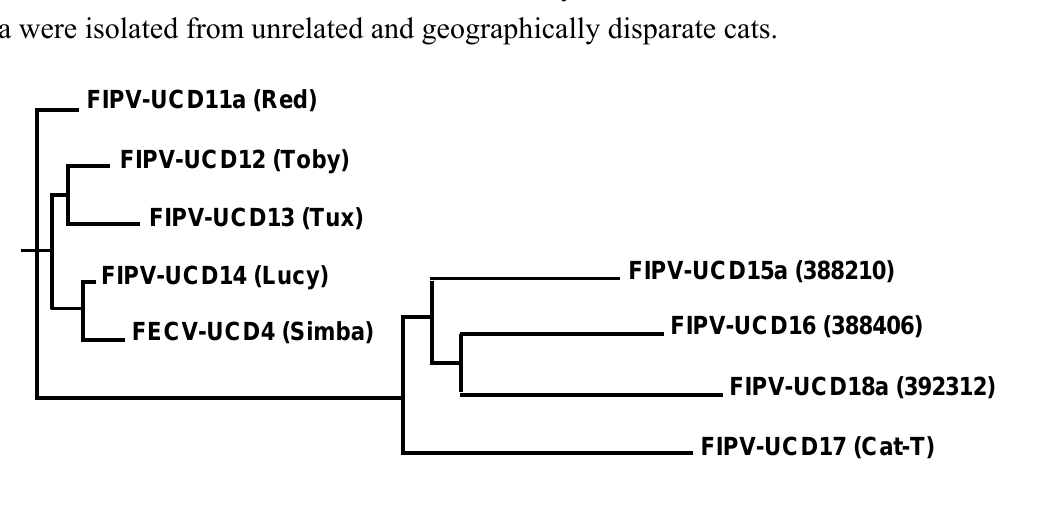
Table 2. Mutational variations in nucleotide and resulting amino acid sequences among the structural and accessory genes of FIPV isolates from four closely related cats involved in the same FIP